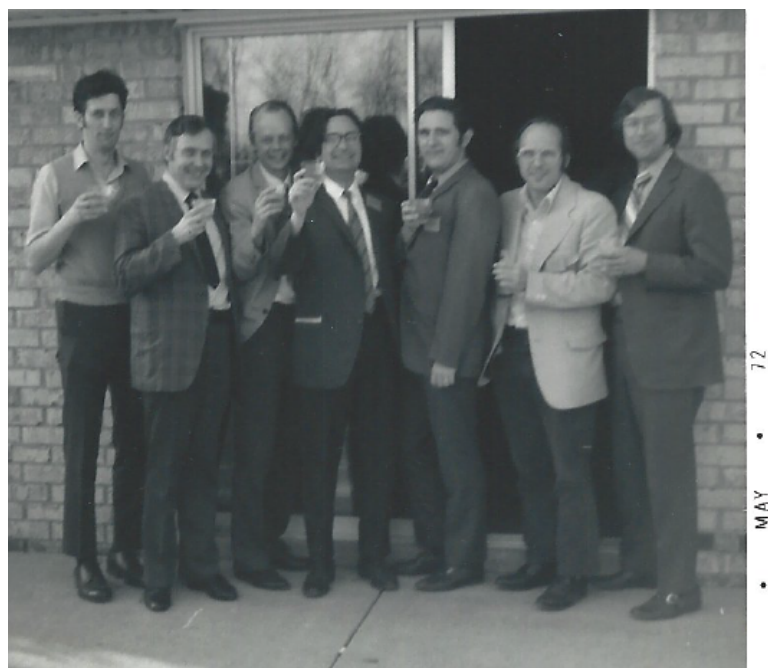
Figure 1: Geert Prins, Lowell Beineke, Edgar Palmer, Frank